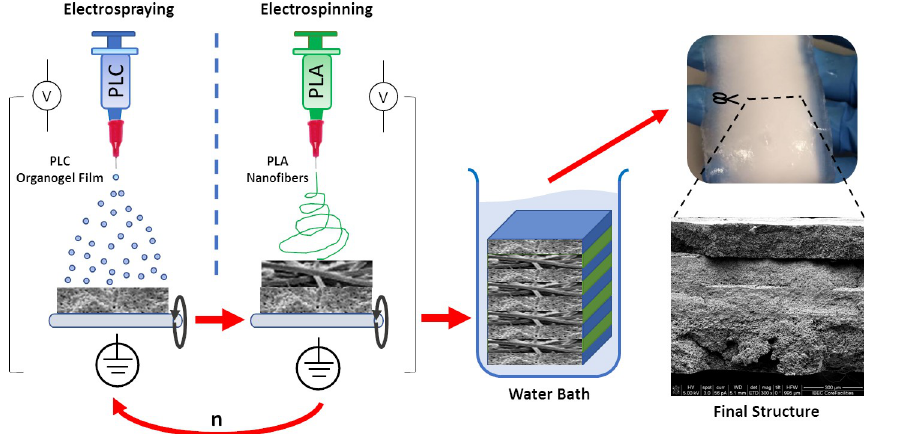
Fig 1. Schematic workflow representation of the RCA device